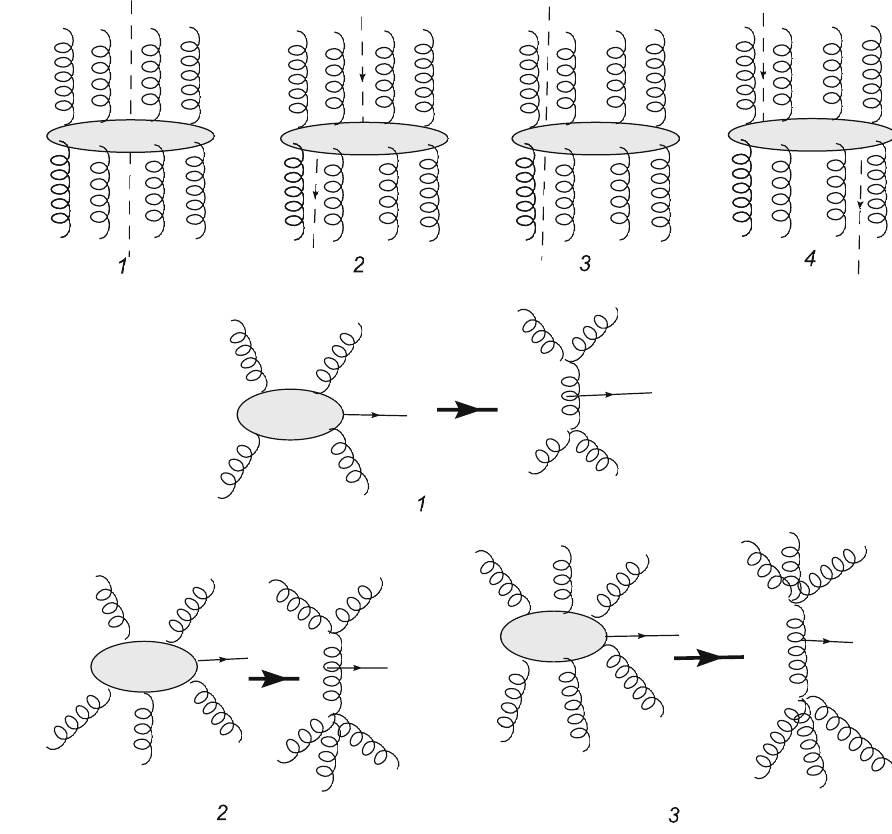
Fig. 10 Cut amplitudes with two reggeons attached to each participant